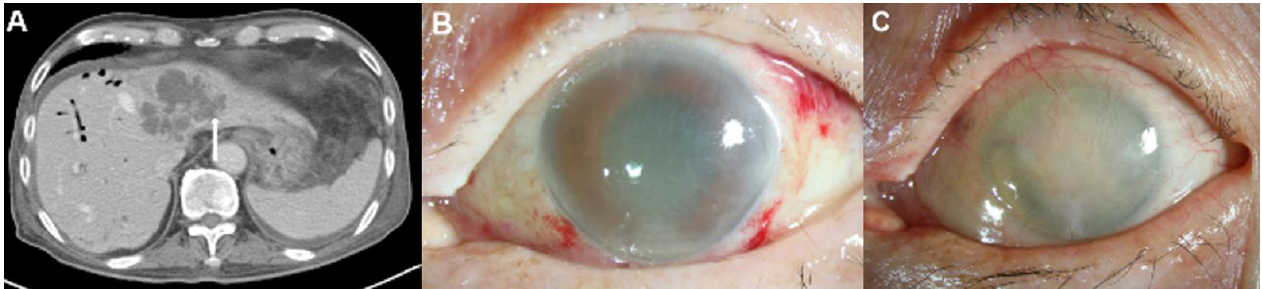
Figure 2. Representative images of a 59-year-old woman with diabetes mellitus who presented with endogenous endophthalmitis due to Klebsiella pneumoniae -related pyogenic liver abscess. ( A ) A contrast- enhanced computed tomography (CT) image showed a 7.5 cm septated cystic lesion, representing a Klebsiella hepatic abscess, at liver segment IV. The CT image also showed thrombophlebitis on the adjacent hepatic vein due to direct invasion from the hepatic abscess (arrow). ( B ) Hyperemia and a 2 mm hypopyon in the anterior chamber were observed in the slit-lamp examination. ( C ) A whitish mass-like lesion, a suspected subretinal abscess, was noticed on wide fundus photograph. Both the slit-lamp examination and the fundus photograph indicated signs of endophthalmitis.